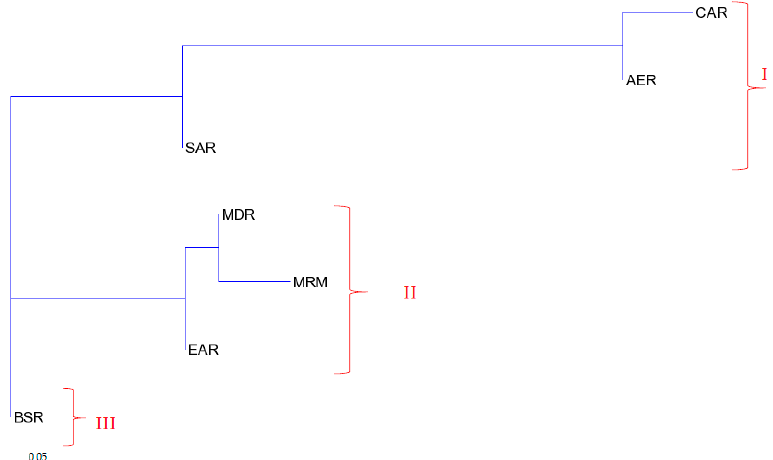
Figure 4. Neighbor-joining tree from Reynolds’ linearized genetic distances in Turkish donkeys from different regions. (CA: Central Anatolia; AEG: Aegean; SEA: Southeastern Anatolia;